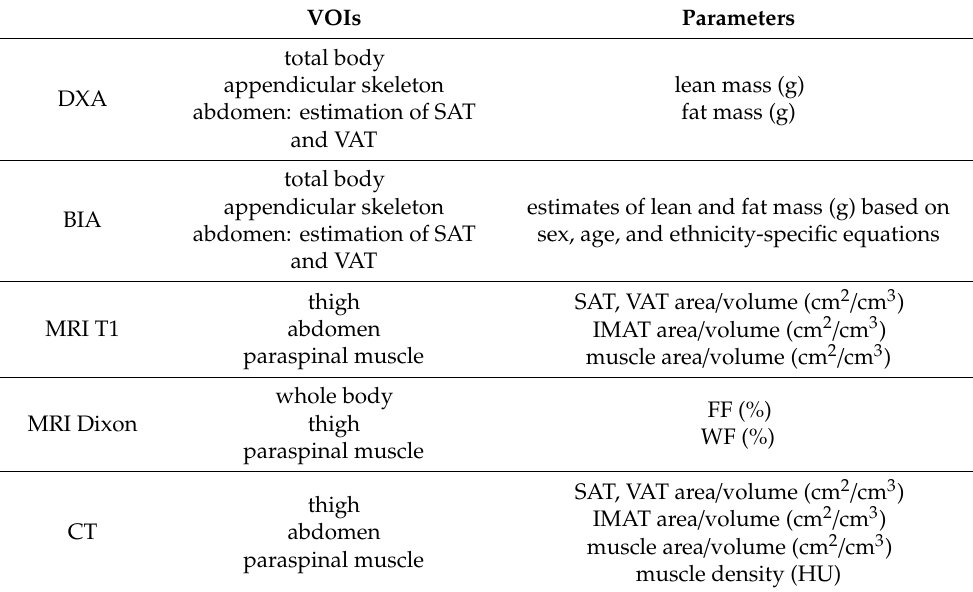
Table 2. Standard anatomical locations (VOI: volume of interest) and standard parameters quantified by dual x-ray absorptiometry (DXA), bioelectrical impedance (BIA), magnetic resonance imaging (MRI) using T1-based or Dixon sequences and computed tomography (CT) in muscle and body composition assessments. HU: Hounsfield units; SAT: subcutaneous adipose tissue; VAT: visceral adipose